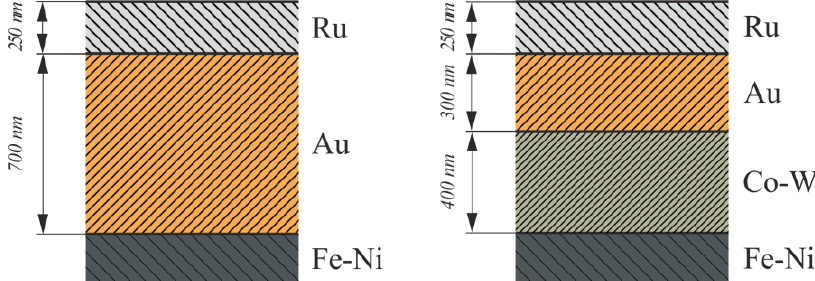
Figure 1. The structure of Au–Ru layers-based contact coatings with and without Co–W barrier sublayer.